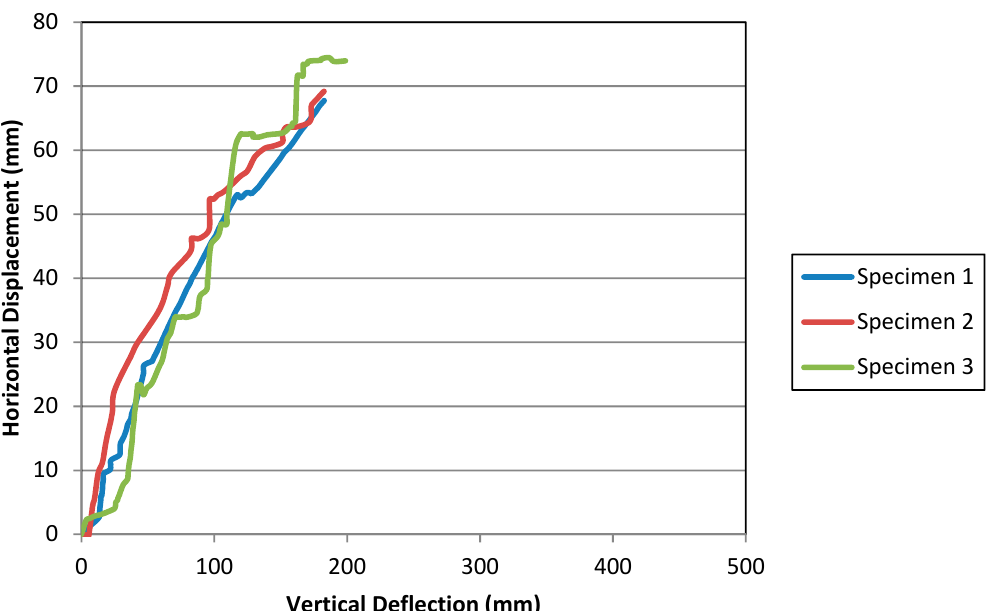
Figure 25. Horizontal displacement at the top LVDT versus vertical deflection.